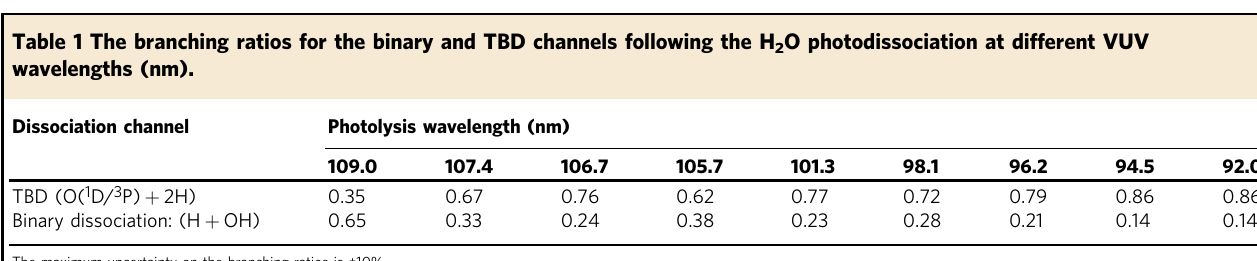
The maximum uncertainty on the branching ratios is